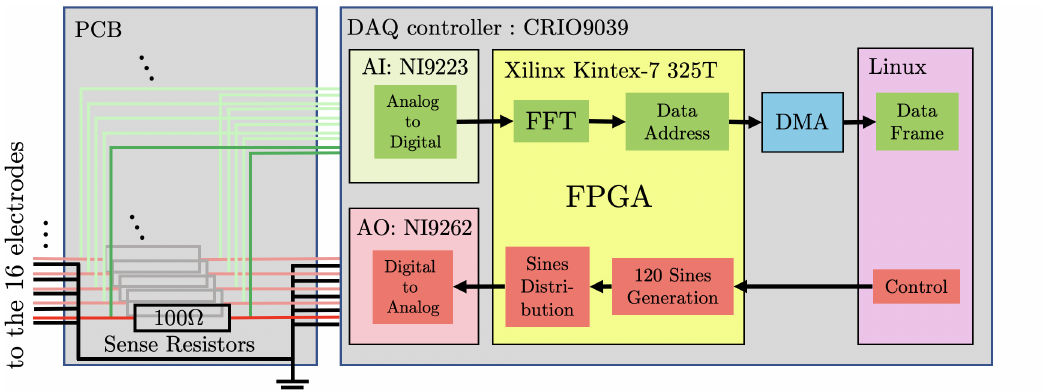
Figure 3. Layout of the DAQ system. On the left, details of the PCB that includes 16 independent circuits for voltage measurements over 100 Ω resistors. On the right, the FPGA-based CRIO-9039 configuration containing four NI-9223 AI modules, three NI-9262 AO modules, and a Direct Memory Access (DMA) buffer all controlled by the host, operated by Linux. In red, the excitation circuit. In green, the measurement